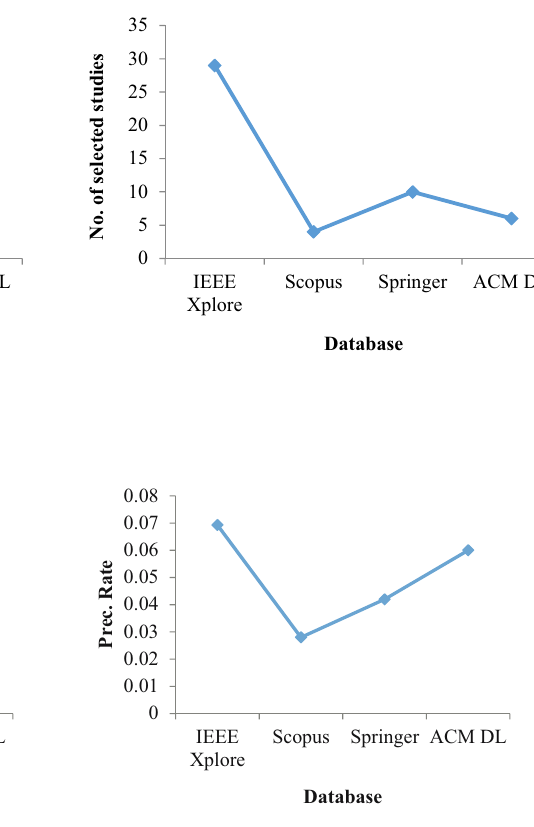
Figure 8: Selected criteria study and the preceding